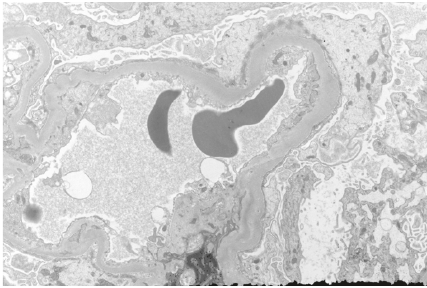
Figure 3: Electron micrograph of a glomerular capillary shows thickened glomerular basement membrane and diffuse foot process effacement.